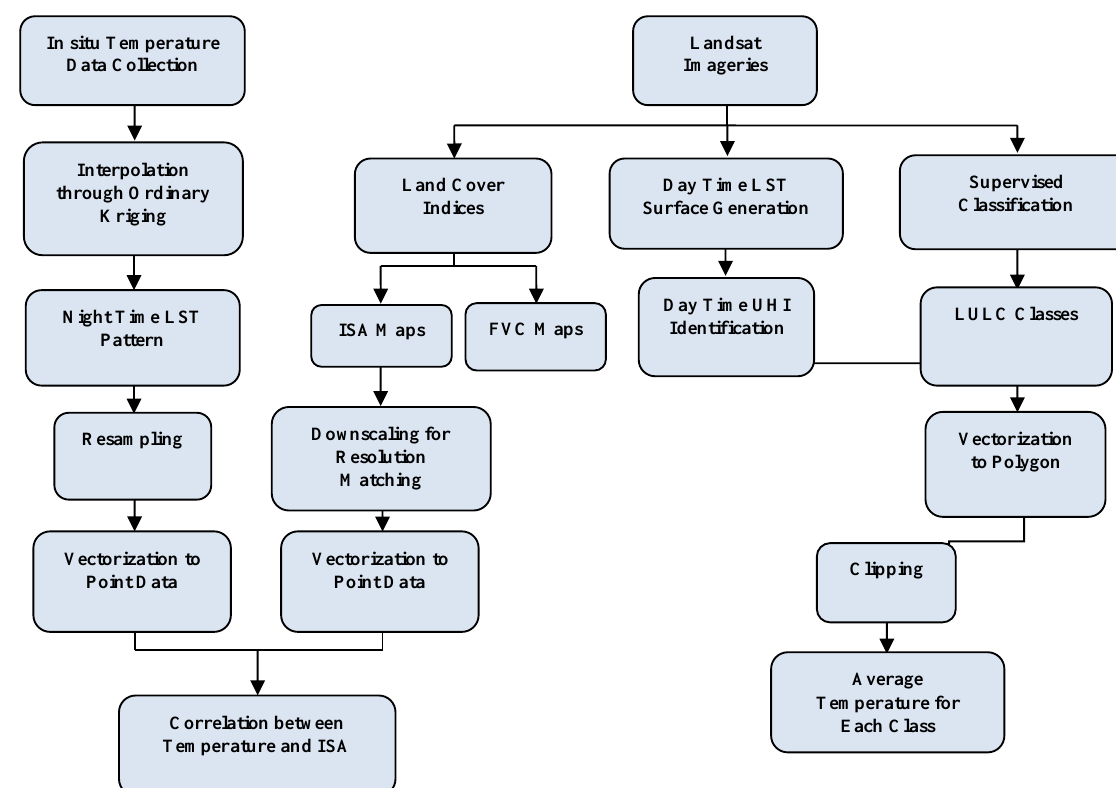
Figure 3. Flow chart of methodology